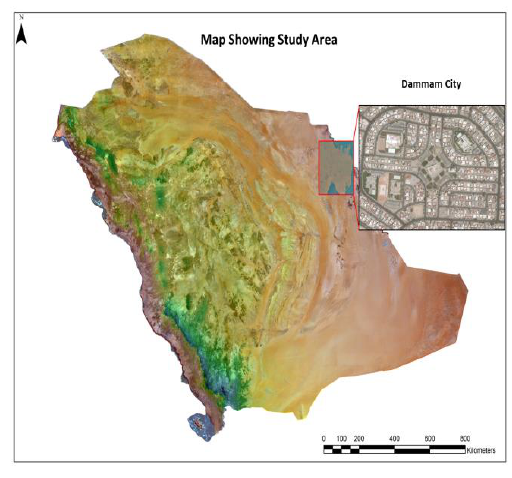
Figure 1. Showing study area of Dammam City The port city is well connected by road, rail, and air with the rest of Saudi Arabia, as well as with its neighboring countries.